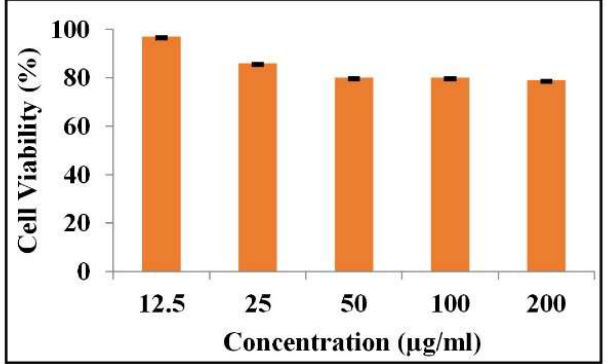
Figure 6. Cell viability of HAp-ZnO composite against MG-63 cell